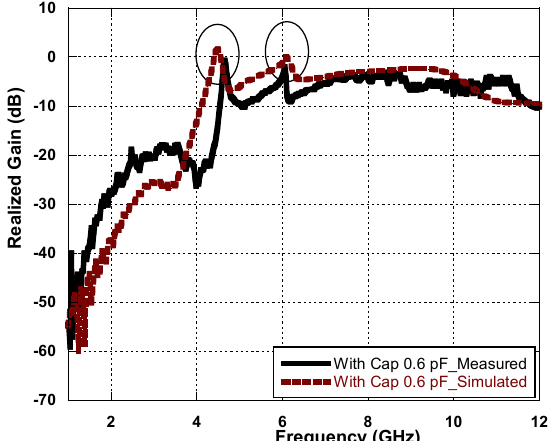
Figure 4. The simulated and measured realized gains.